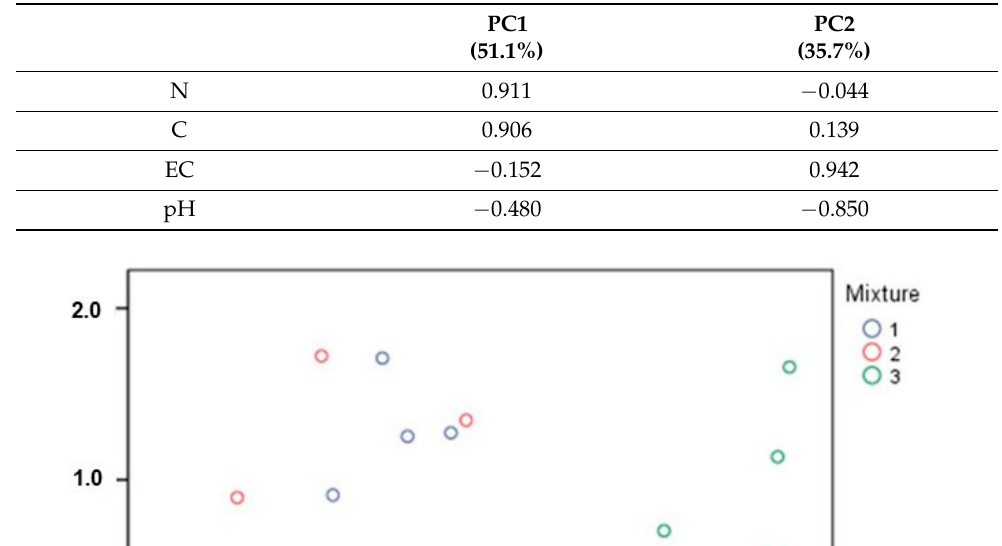
Table 3. Matrix of PCA obtained with N, C, EC, and pH in all mixtures.